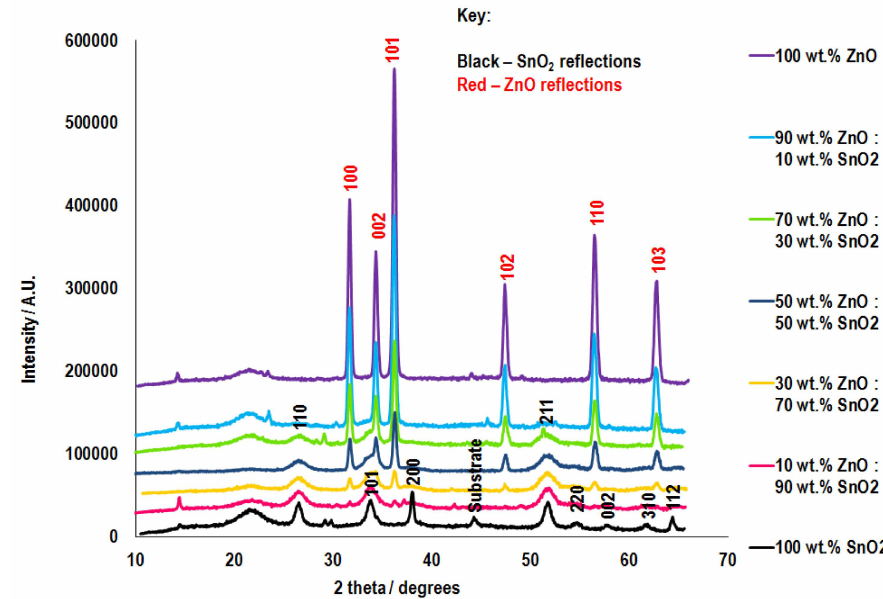
Figure 2. XRD patterns of pure and composite sensors based on SnO 2 and ZnO metal oxides, in the SnO 2 -ZnO composite array. All materials were screen-printed and heat-treated at 600 ˝ C, prior to XRD